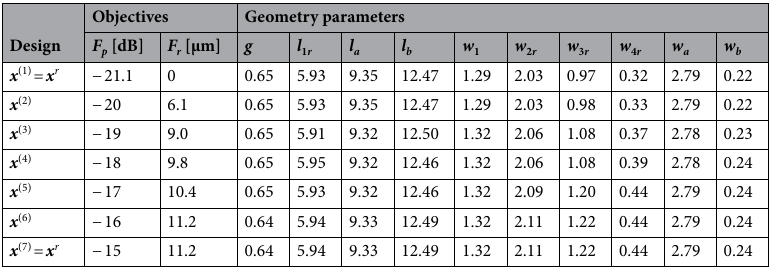
Table 2. Results of multi-criterial design with robustness evaluation for a compact BLC of Fig. 8